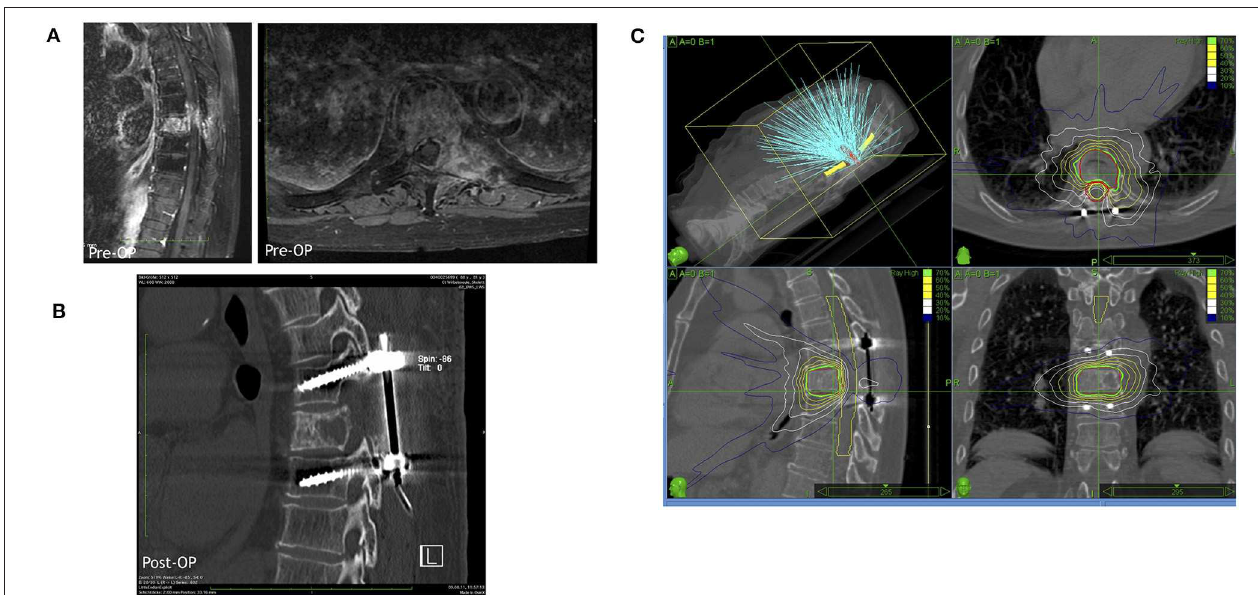
FIGURE 3 | A representative case for a hybrid therapy with a prior surgery including decompression and stabilization followed by a radiosurgical treatment by Cyberknife. (A) Representative MRI images (left in sagittal view and right in axial view) of the metastatic lesion in thoracic vertebra 8. (B) Postoperative CT scan demonstrating the decompression in the lesional segment and dorsal spinal fusion of thoracic vertebra 7 and 9. (C) The Cyberknife treatment planning of the lesional vertebra body after